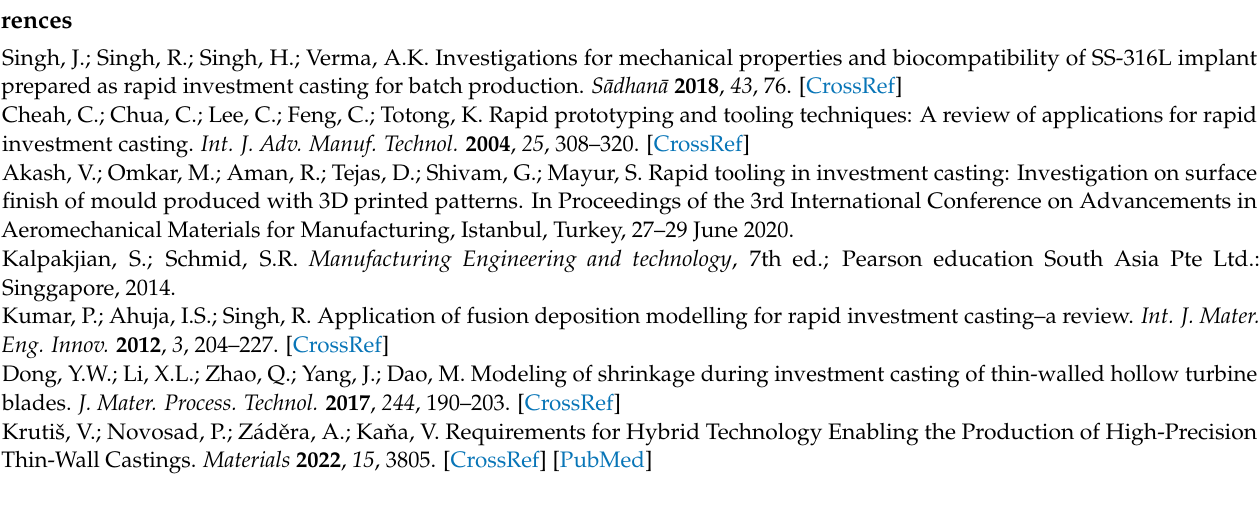
Influence of layer thickness on the surface roughness in 3D printed part using PLA and casted product; Figure S4: Printing time, weight, and tensile properties of the printed patterns using PLA with the variation of infill density; Table S1: Printing time and weight of PLA printed pattern with the variation of infill